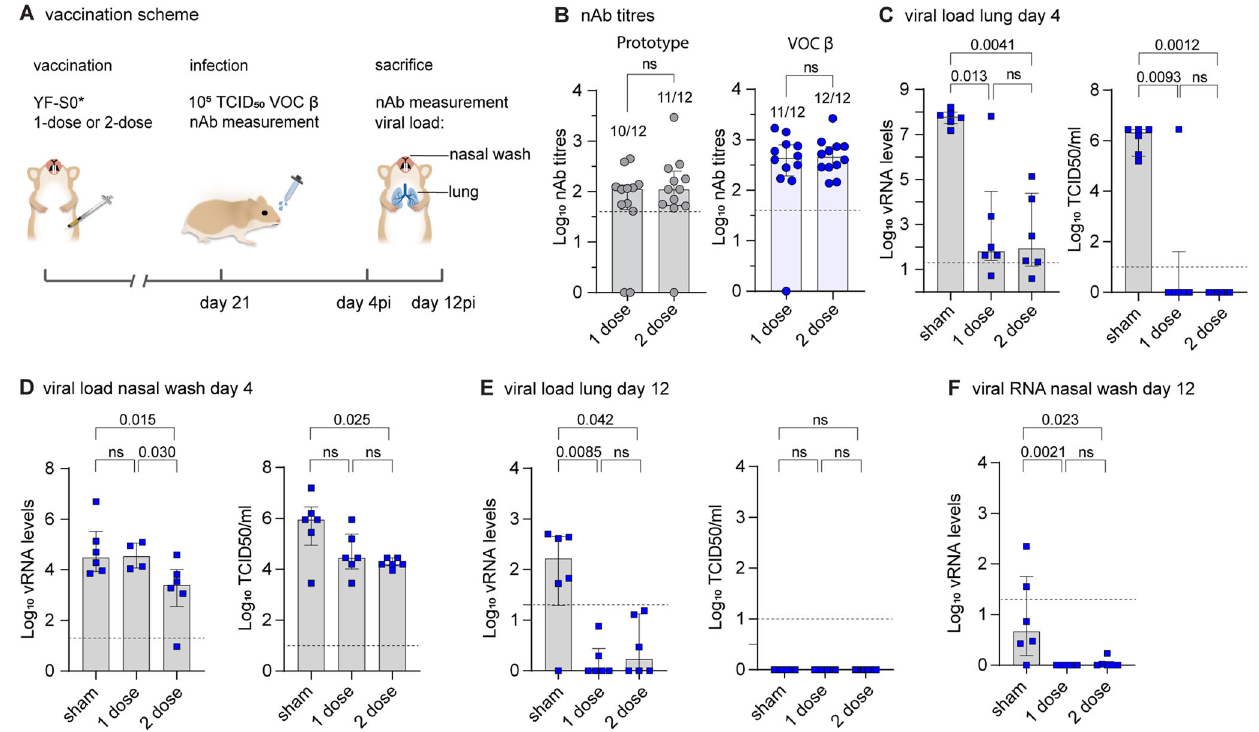
Fig. 3 | Protection by YF-S0* against vigorous high-dose VOC Beta challenge. A Vaccination scheme with updated YF-S0*. Syrian hamsters were immunized either once ( n =12) or twice ( n =12) intraperitoneally with 10 4 PFU of YF-S0* and n =12hamsterswereshamvaccinatedandinoculatedintranasallyonday21with10 5 median tissue-culture infectious dose (TCID50) of VOC Beta. Animals were sacri- fi ced on either day 4 ( n =18) or day 12 ( n =18) after infection (each timepoint n =6 each per group; once or twice YF-S0* vaccinated, and sham). B nAb titres against prototypic (gray circles) and VOC Beta (blue circles) spike-pseudotyped virus on